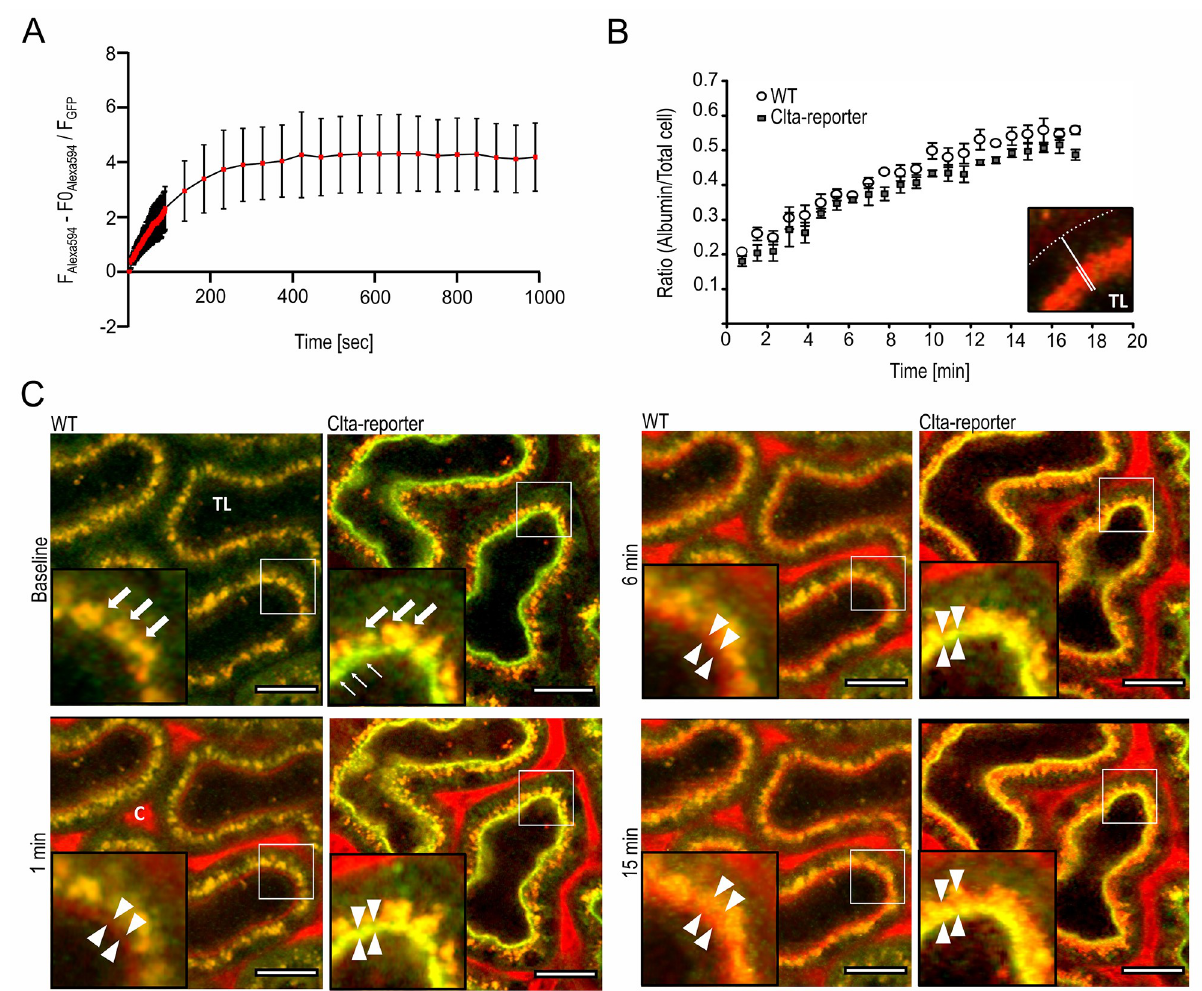
Fig 6. In vivo imaging of Alexa594-BSA uptake in Clta-reporter and WT animals. ( A ) Calculated ratio of Alexa594-BSA (background corrected) and Clta-eGFP signal at the apical area in PTEC. Alexa594-BSA quickly accumulates in the Clta-eGFP-positive region of S1 proximal tubules, before a steady state of albumin influx and outflux is reached. A one-phase association non-linear fitting determined a half-time for Alexa594-albumin in the Clta-eGFP-positive proximal tubule compartment of 85.53 seconds. Analysis was performed for Clta-reporter animals only, as the defined eGFP signal at the brush border was used for segmentation of the subapical area. Graph shows mean ± SEM. ( B ) Analysis of Alexa594-BSA uptake in Clta-reporter and WT animals over time was assessed as the ratio of the thickness of Alexa594-albumin-fluorescent region over the total thickness of the respective PTEC for each time point (B inlet, for different time points see S6 Fig in S1 Appendix). No significant difference can be detected at any time point tested (2-way Anova multiple comparison analysis). Dotted line represents basal cell border. TL: lumen. ( C ) Intravital 2-photon microscopy images of WT and Clta-reporter mouse S1 segment proximal tubules (PTs), before (baseline) and 1 min, 6 min and 15 min post i.v. injection of Alexa594-BSA (red). Compared to WT PTs, Clta-reporter mice identify clathrin by bright eGFP-expression (green) in the brush border (baseline, arrows). Both genotypes reveal autofluorescent lysosomes (yellow) in the apical region of PTECs (baseline, bold arrows). 1 min after injection, Alexa594-BSA is clearly visible in peritubular capillaries (c) and accumulates in the brush border of WT (red) and Clta-reporter (yellow) PTs (arrowheads). Over time, proximal tubular uptake and intracellular trafficking of Alexa594-BSA, leads to increased thickness of red fluorescent area in the apical region of PT cells (arrowheads), until Alexa594-BSA is clearly visible in PT lysosomes at 15 min. TL: lumen; Scale bar: 20 μ m.